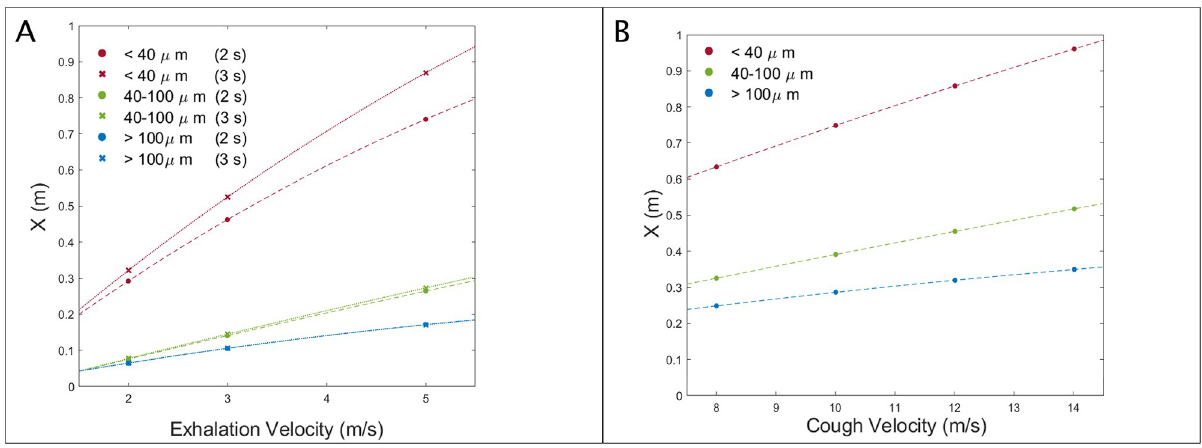
Fig 9. CFD simulations: Particle axial travel distance by diameter. Mean axial travel distance of specified size ranges of droplets for (A) breathing at 6 s after exhalation begins and (B) coughing at 5 s after cough begins.